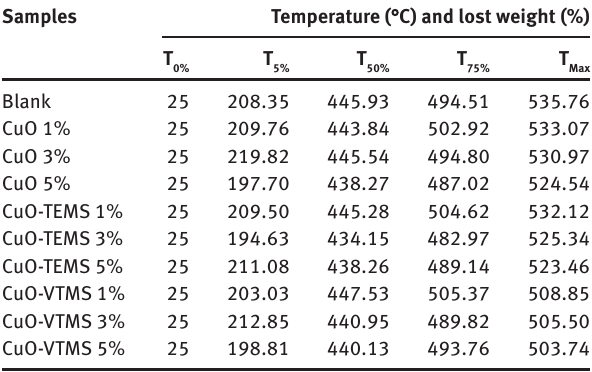
Table 1: Results of thermogravimetric analysis for epoxy acrylate containing nano CuO, nano CuO + TEMS, and nano CuO + VTMS. Samples